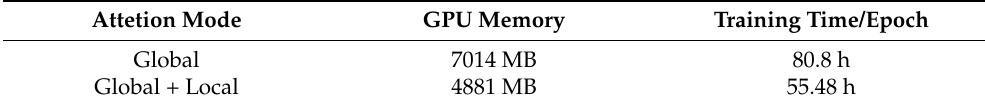
Figure 4. Examples of a generated summary and a golden summary.